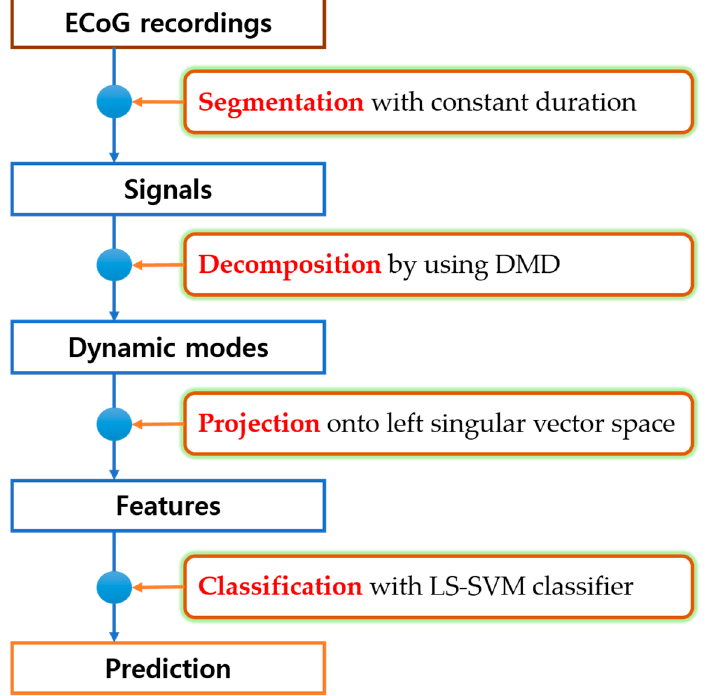
Figure 3. Suggested steps for classification of ECoG recordings.